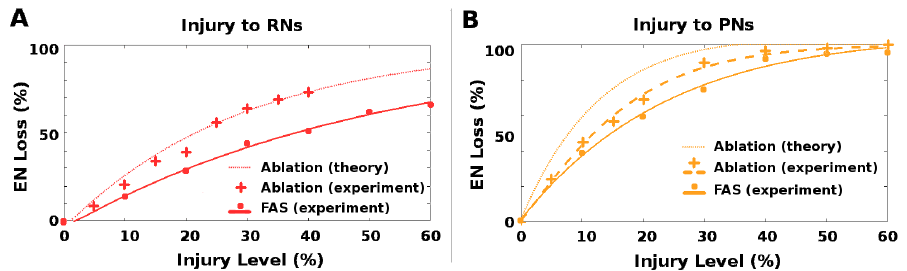
Figure 8. Level of Ablation and FAS injury needed to induce a given EN loss: The relationship of ablation and FAS injury effects varied with injury location, implying that ablation is an unreliable proxy for FAS injury. Key (both plots): dots and crosses are experimental results for FAS (dots) and ablation (crosses). Solid and dashed curves are fits to experimental results for FAS (solid) and ablation (dashed). The dotted curve is the theoretical result for ablation, given the FAS experimental results and a 1.75 × ratio (see Section 5.3.3). ( A ) When RNs were injured, ablation induced loss to EN response consistent with theory (1 unit Ablation ≈ 1.75 units FAS injury). Curves do not meet at origin because they are fits to data points. ( B ) When PNs were injured, ablation induced a much smaller loss than theory would suggest (1 unit Ablation ≈ 1.25 units FAS injury). This can be seen by looking at horizontal lines (i.e., fixed EN loss), and comparing injury levels that induce this loss for (from right to left) experimental FAS injury, experimental ablation, and theoretically-expected ablation.